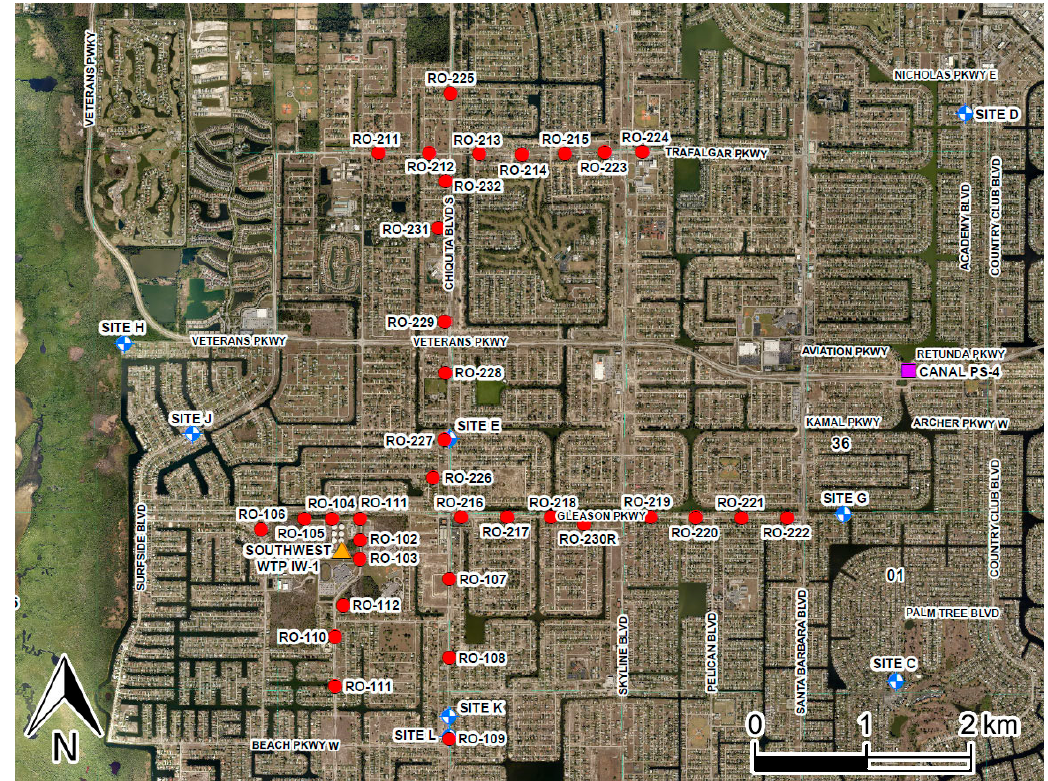
Figure 2. Process diagram for the South Cape Coral BWRO [26].